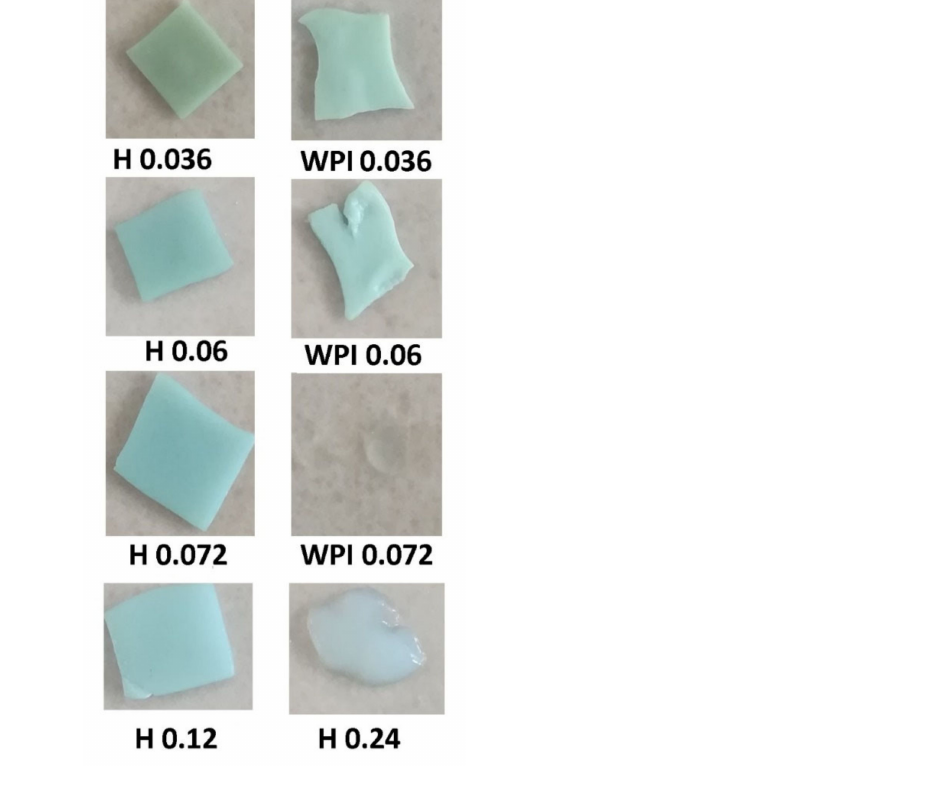
Figure 7. Photographs of hydrogel samples after a week spent in swelling